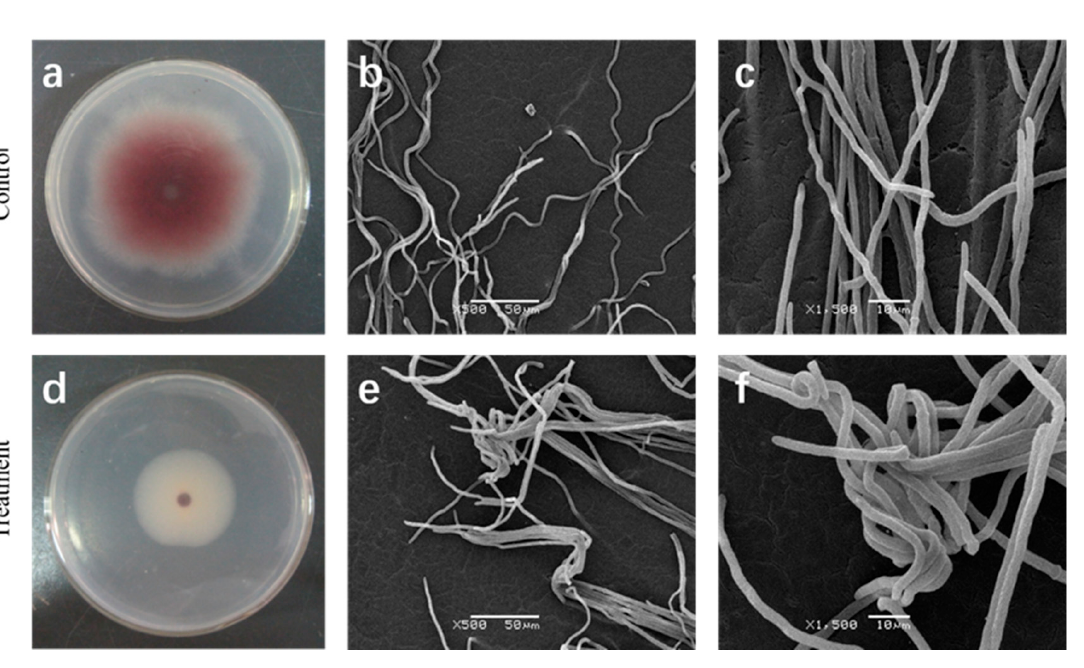
Figure 2. Mycelial relative conductivity of FON with or without cuminic acid treatment at the concentration of EC 50 value (22.53 μ g/mL). Values are means and standard errors.